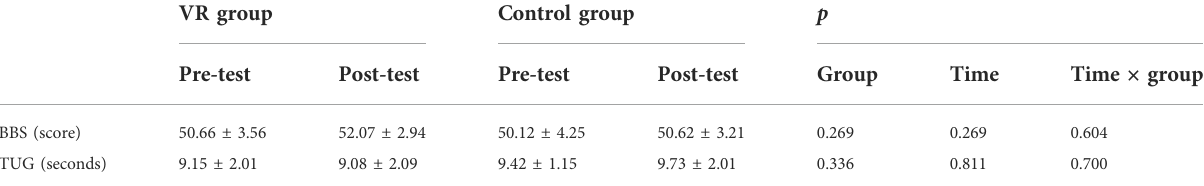
TABLE 3 The balance ability in adolescents with ID (X ± S).